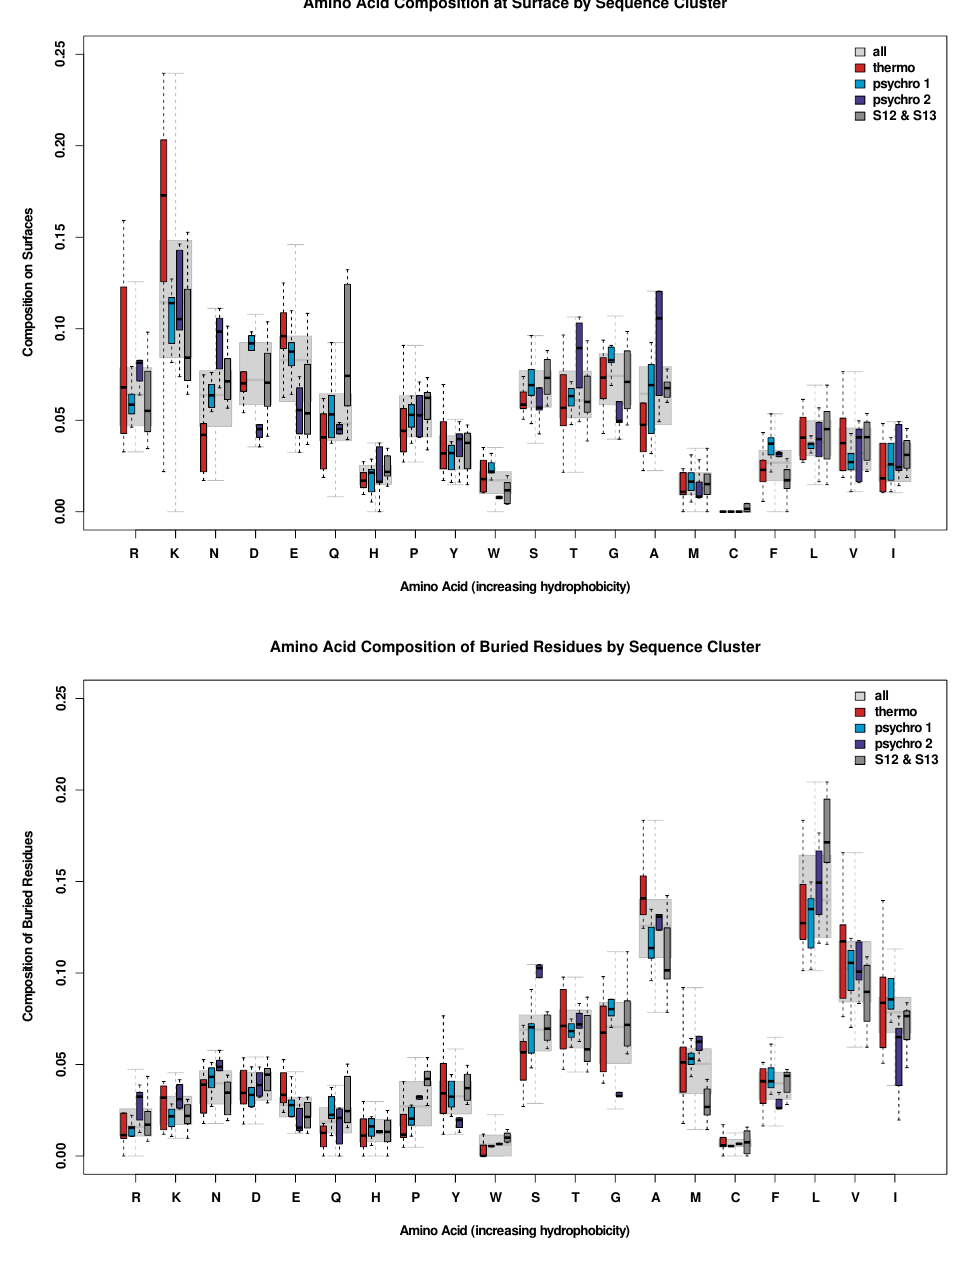
Figure 5. Rate of exposure ( top ) and burial ( bottom ) of residues by amino acid type for all proteases in each sequence cluster (Figure 1), as well as for S12 and S13 sequences (combined). “Exposed” residues had relative SASA values greater than 0.2, with the remaining residues considered to be